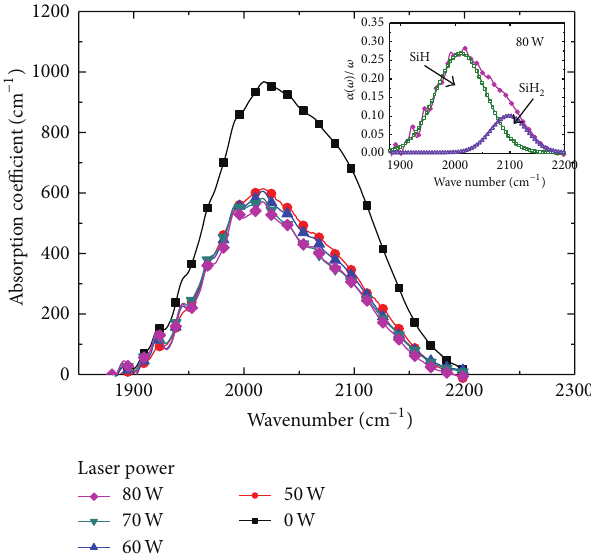
Figure 3: Absorption spectra 𝛼(𝜔) of the i-Si films deposited with various assisting laser powers. The inset shows the absorption spectrum 𝛼(𝜔)/𝜔 of the i-Si films with assisting laser power of 80 W.